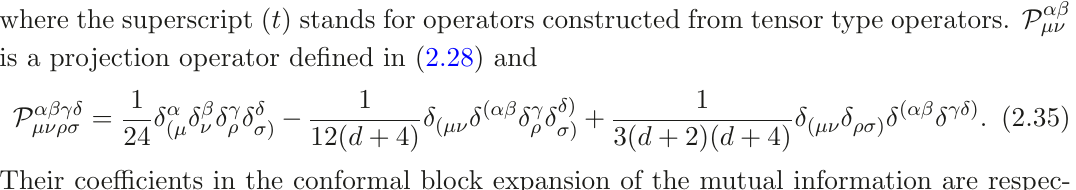
Figure 1 . The mutual information between two boundary regions A and B can be computed holographically by exchanging the bulk fields. Here the distance between A and B is much larger than their radius. A b and B b are bulk regions enclosed by the corresponding minimal